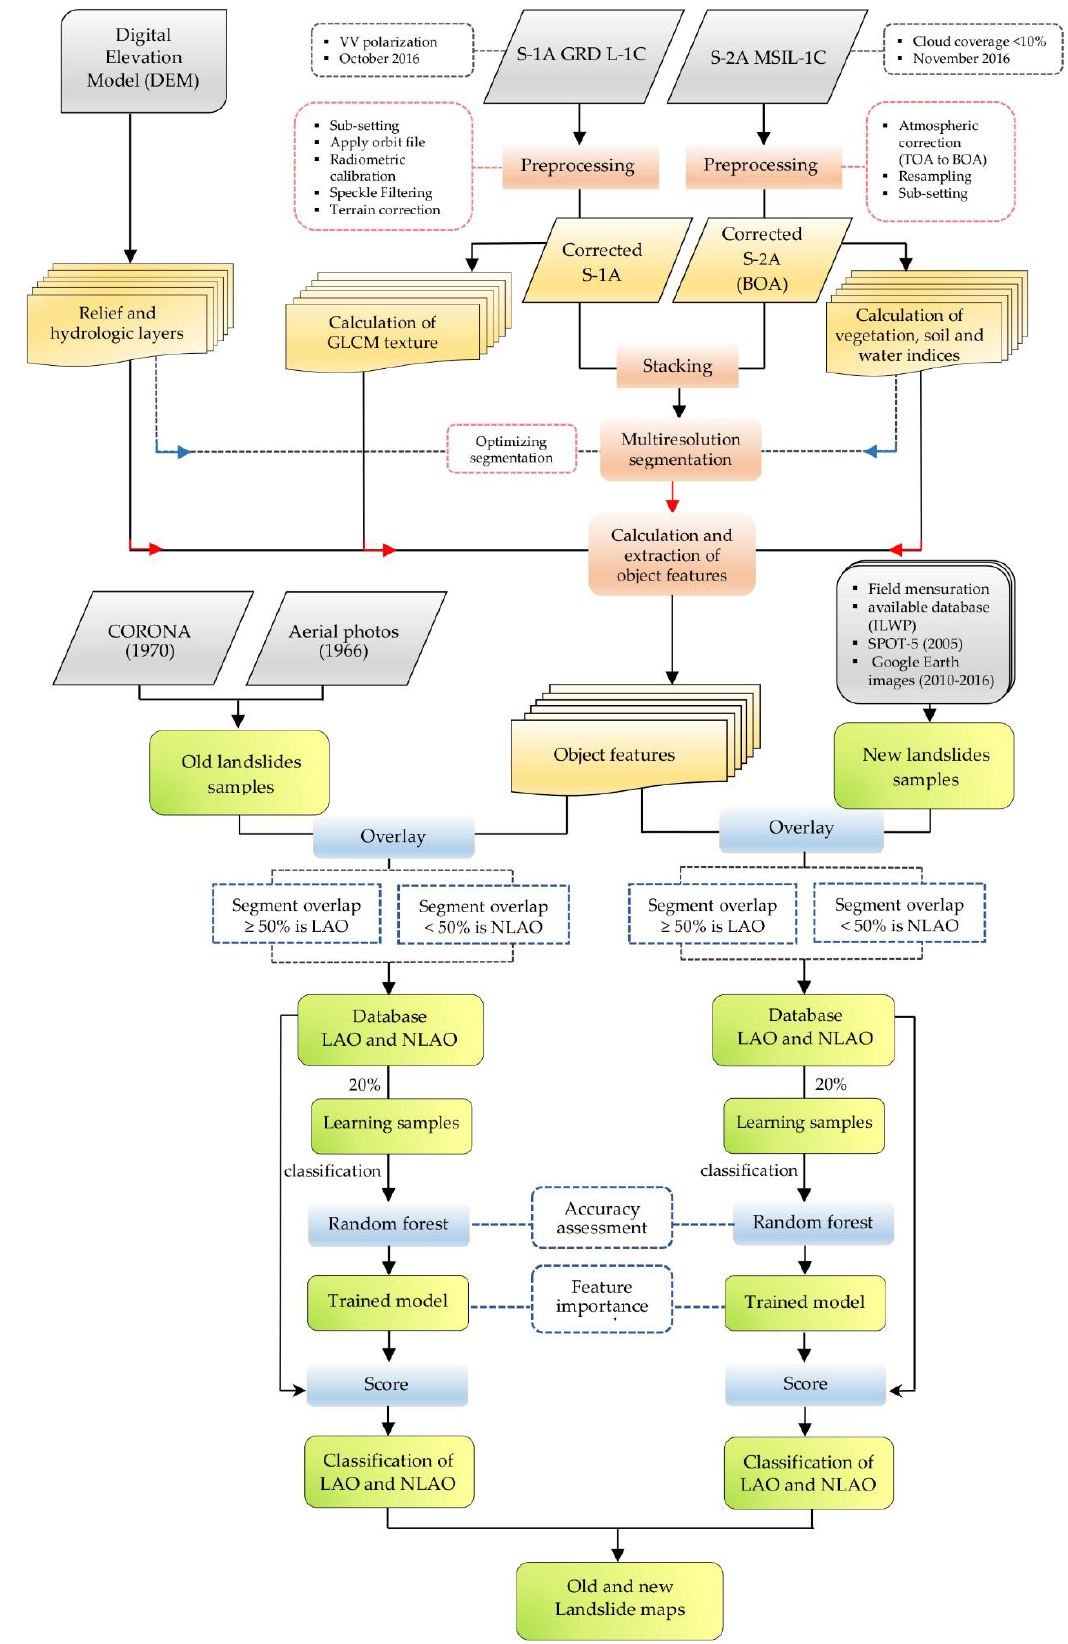
Figure 3. The procedure of discriminating landslide objects from non-landslide objects through object-oriented random forest using derived features of Sentinel-1 and -2A, and topographic and hydrologic data in the protected forests and non-protected forests of NE Iran.